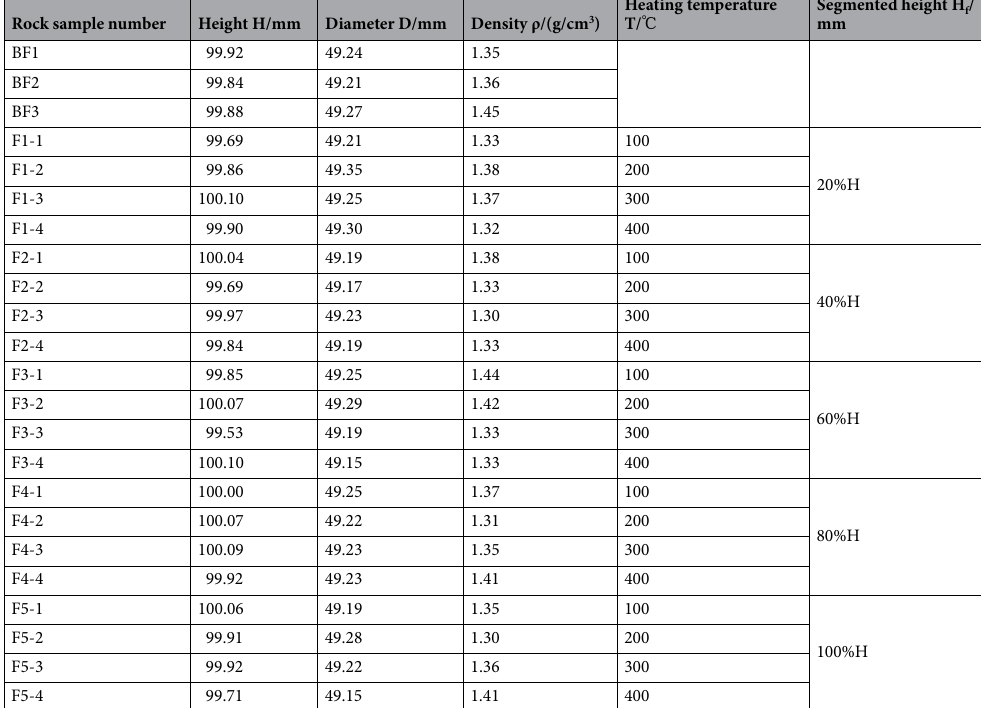
Table 1. Loading mechanical test scheme after segmented high-temperature treatment.